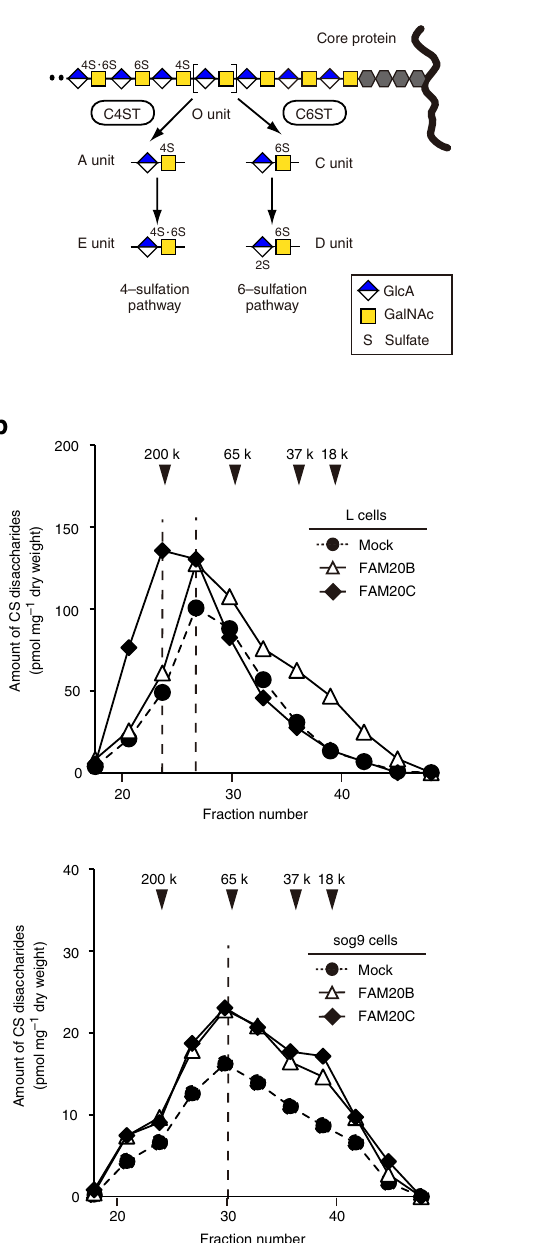
soluble forms of His-tagged C4ST-1 and FLAG-tagged FAM20 proteins. Data are obtained from three independent experiments and representative images are shown. d Sulfotransferase activities of C4ST-1 alone (Mock) and that from cells co- transfected with the individual FAM20 proteins ( n =3 independent experiments, Dunnett ’ smultiplecomparisontest,two-sided). e The4S/6SratioofCSchainsfrom HeLa cell lines overexpressing wild-type or mutant FAM20C proteins ( n =4 inde- pendent experiments, Dunnett ’ s multiple comparison test, two-sided). Data in d and e are represented as the mean±s.d. Source data are provided as a Source Data fi